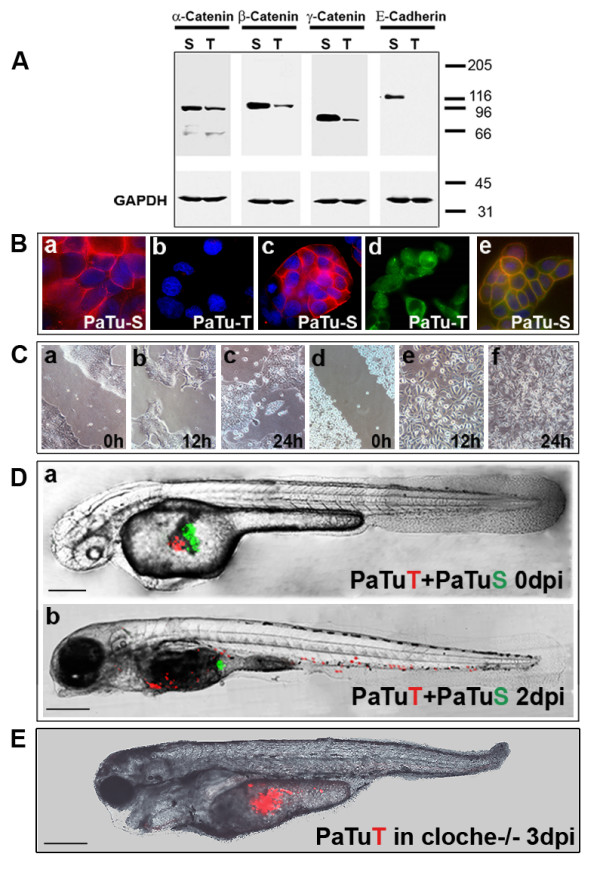
Implantation of two pancreatic cancer cell lines into the same zebrafish embryo. (A) Western blot analysis shows that PaTu-S but not PaTu-T cells express E-cadherin and both express α-, β- and γ-catenin. GAPDH expression is shown as a control. (B) Cellular localization of E-cadherin and β-catenin was analysed by immunofluoresscence. E-cadherin expression is shown for PaTu-S cells (a) and absence of E-cadherin expression for PaTu-T cells (b). Dapi staining was used to visualize cell nuclei in blue. β-catenin localization is shown for PaTu-S (c) and for PaTu-T (d). Co-localization of E-cadherin (green) and β-catenin (red) in PaTu-S cells is indicated by yellow staining of the plasmamembrane (e). (C) An in vitro migration assay ('scratch assay') shows differences in migration of the two cell lines (PaTu-S: a-c and PaTu-T: d-f). Similar results were obtained in four independent experiments. Gap closure (gap width) over time is shown in Additional file 5. (D) Non-invasive PaTu-S cells (green) and invasive PaTu-T cells (red) were implanted consecutively in the same embryo (a and b) (Scales: 250 μm (a) and 300 μm (b)). (E) Homozygous cloche mutants [17] were injected with PaTu-T cells and followed over time. Shown is an example of a cloche-/- zebrafish at 3 dpi (scale bar: 300 μm). In contrast to control zebrafish none of the tested cloche-/-mutants showed any sign of metastatic behaviour (see Additional file 1 and Additional file 7). The cloche phenotype and its lack of a functional vasculature and circulation is observable by DIC microscopy (see Additional file 6).